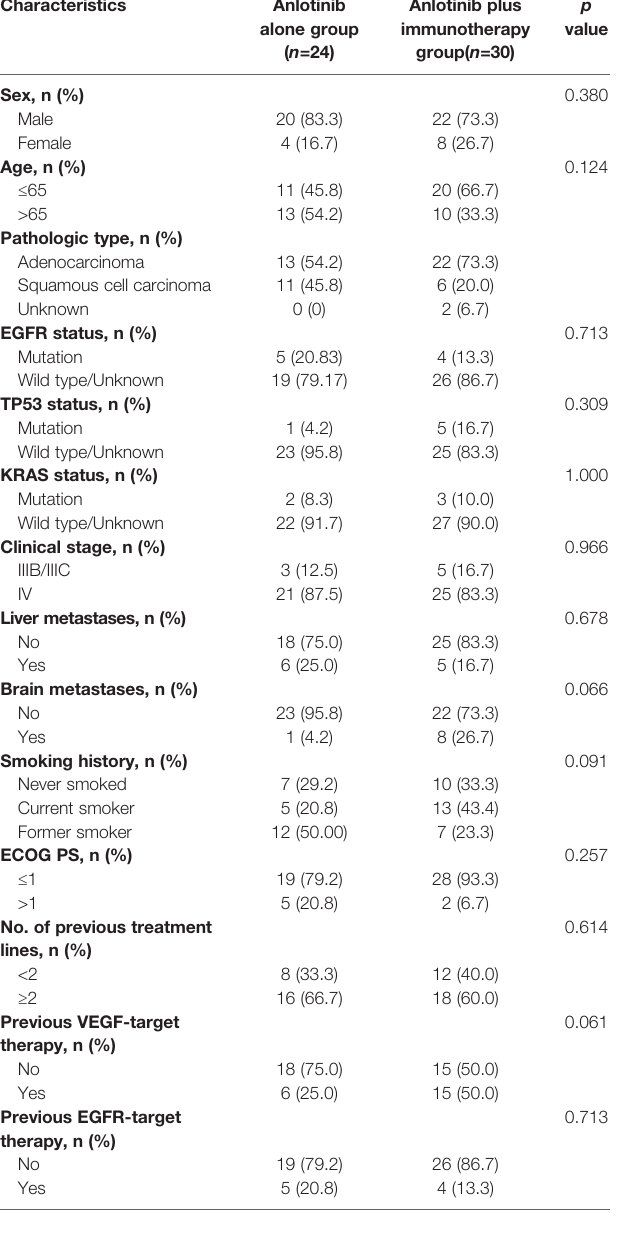
TABLE 3 | Comparison of clinical characteristics of patients receiving anlotinib alone and those receiving anlotinib plus immunotherapy. Characteristics